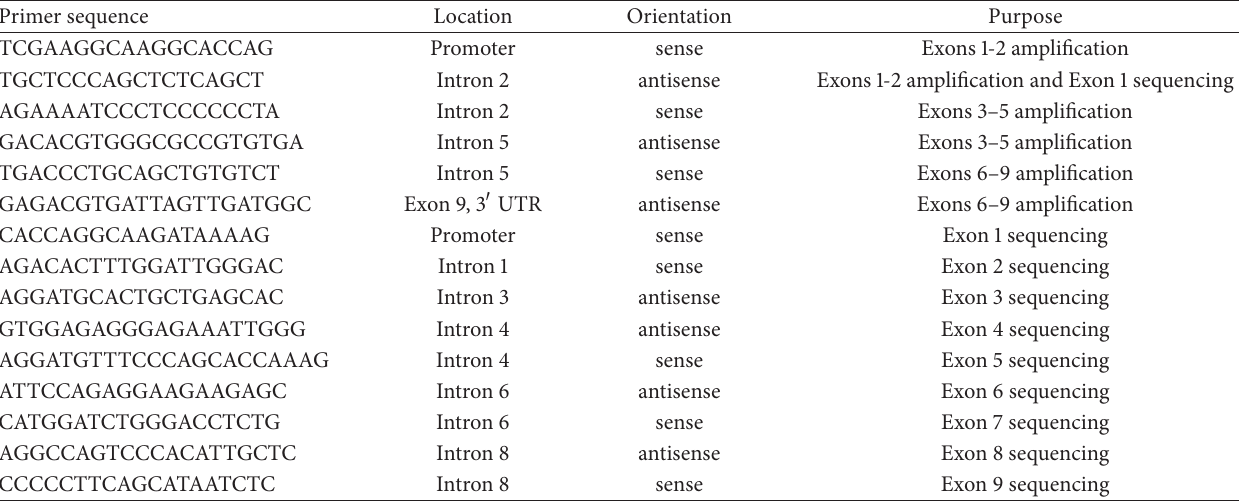
Figure 4: p.R141 is conserved in mammalian CYP11B1 protein. The GenBank protein sequences used for the alignment were NP 000488.3 ( Homo sapiens , Human), NP 001180667.1 ( Macaca mulatta , Rhesus Monkey), XP 002759236.1 ( Callithrix jacchus , White-Tufted-Ear Mar- moset), NP 777063.2 ( Bos taurus , Cattle), NP 001068568.1 ( Ovis aries , Sheep), NP 001166410.1 ( Cavia porcellus , Guinea Pig), NP 001028401.2 ( Mus musculus , Mouse), and NP 036669.3 ( Rattus norvegicus , Rat). p.R141 is in bold letter. Fully (asterisk), strongly (colon), and weakly (period) conserved residues are indicated. Table 2: List of primers for PCR amplification and DNA sequencing of the CYP11B1 gene. Primer sequence